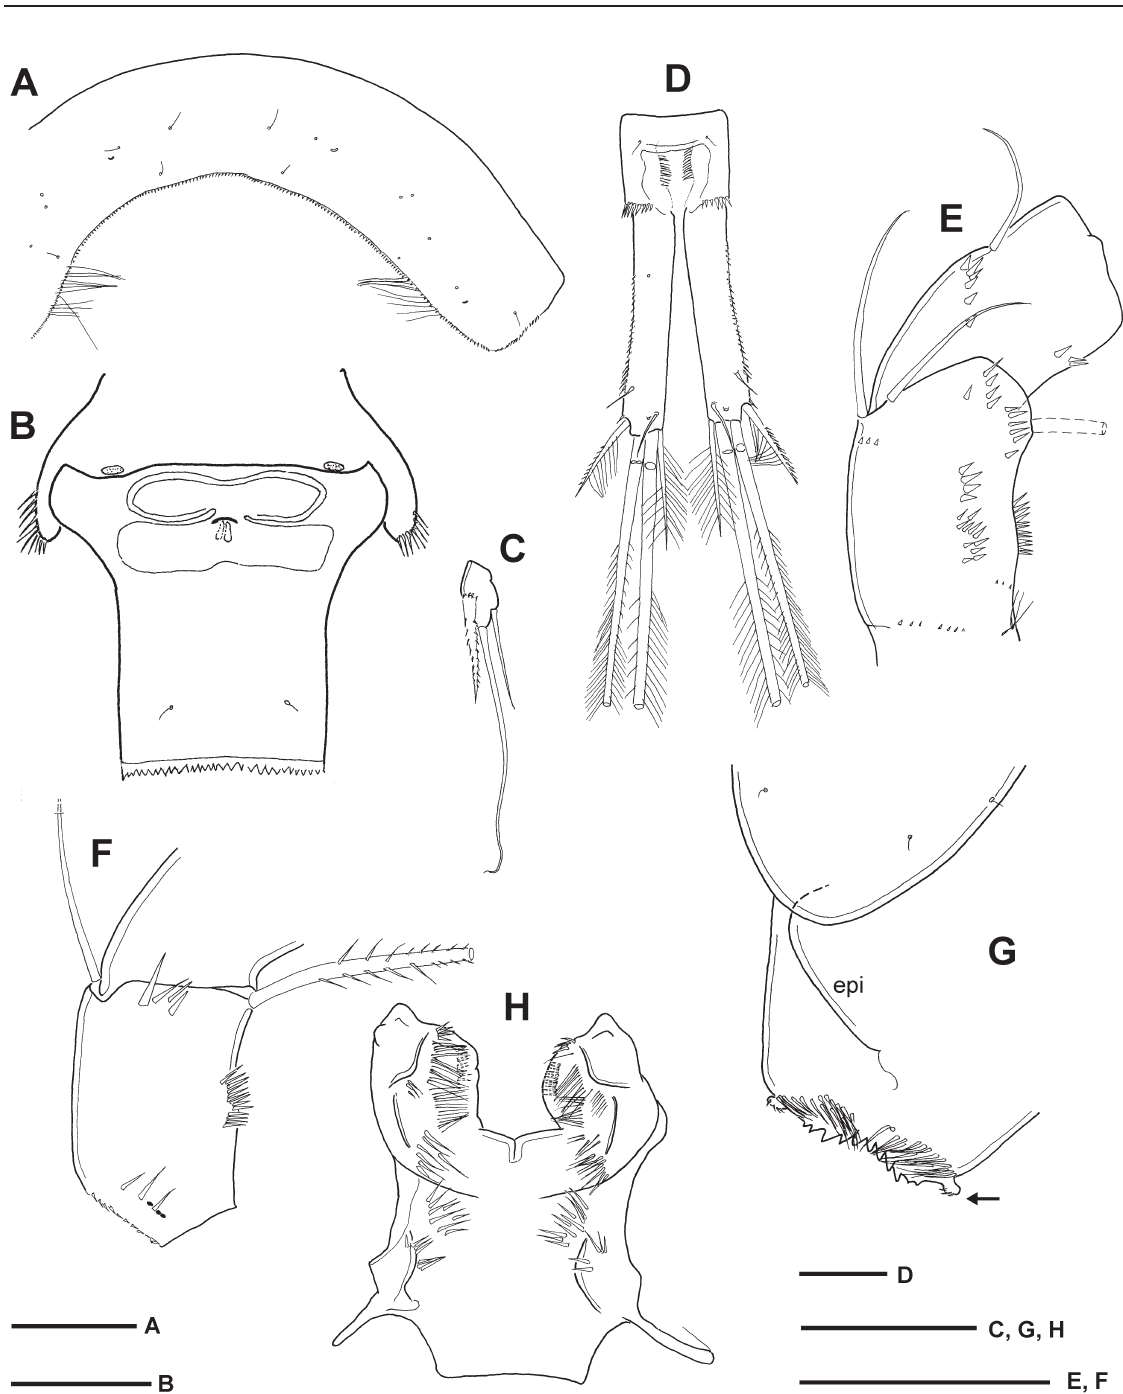
Fig. 8. Eucyclops agiloides (G.O. Sars,1909), ♀ (Lake Tanganyika, Kirando; NHM). A . Pediger 4, dorsal view. B . Pediger 5 and genital double-somite (leg 5 is not figured), ventral view. C . Leg 5. D . Anal somite and caudal rami, dorsal view. E . Antennal coxobasis and first endopodal segment, caudal view. F . Antennal coxobasis, frontal view. G . Labrum – ʻepiʼ shows epistoma, laterodistal lobe is indicated by arrow. H . Paragnaths, ventral view (3+1 medial claws inserted on opposite surface of both paragnaths are not figured). A, D−H show ♀-1; B−C show ♀-2. Scale bars: A−H = 50